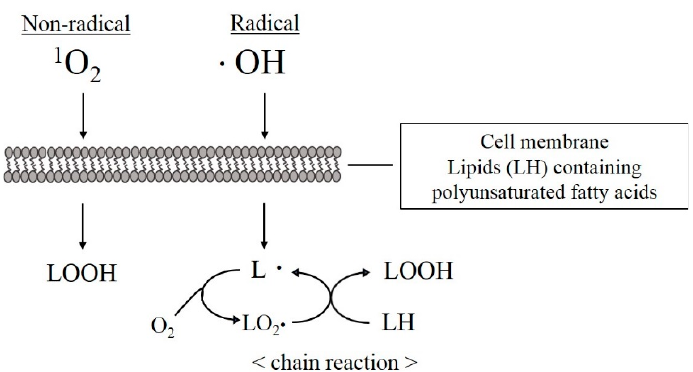
Figure 10. Differential effects of radical and non-radical reactions. Non-radicals are stoichiometric reactions that oxidize the target molecule and terminate the reaction, whereas radicals oxidize the target molecule and generate new radicals at the same time, and the reaction continues repeatedly.